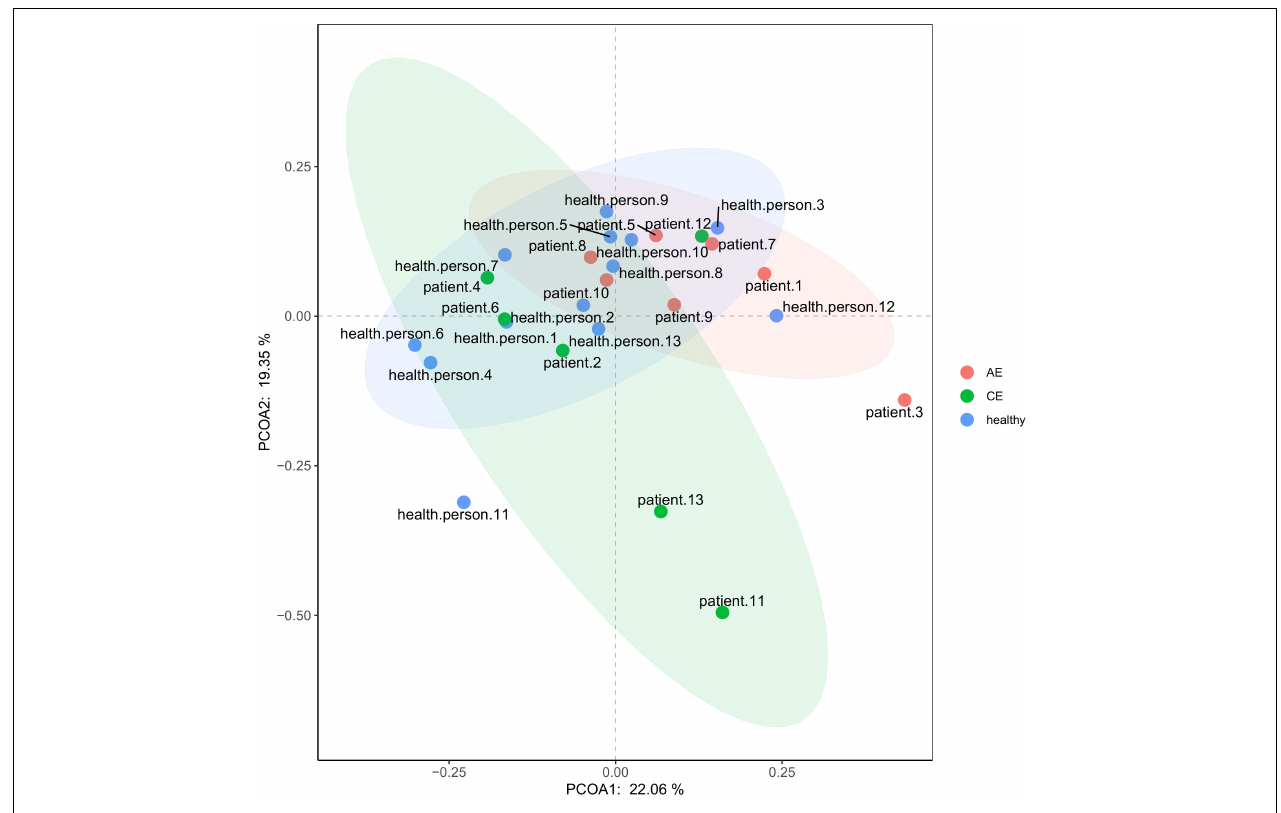
FIGURE 6 | PcoA (principal co-ordinates analysis) analysis